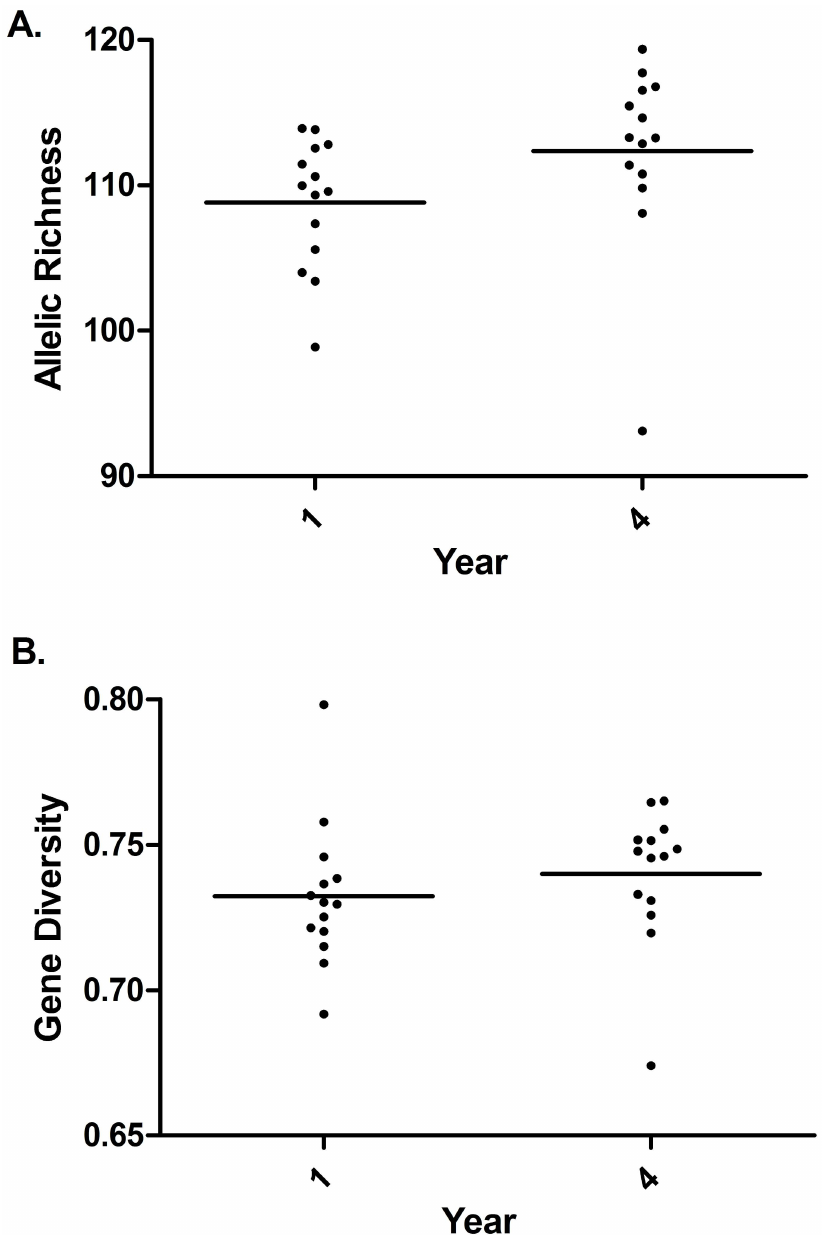
Figure 3. Mean changes in genetic diversity of schistosomes collected from humans before and after four years of an annual mass treatment program. Lines indicate means. Data are corrected for sibling structure. A. allelic richness B. gene